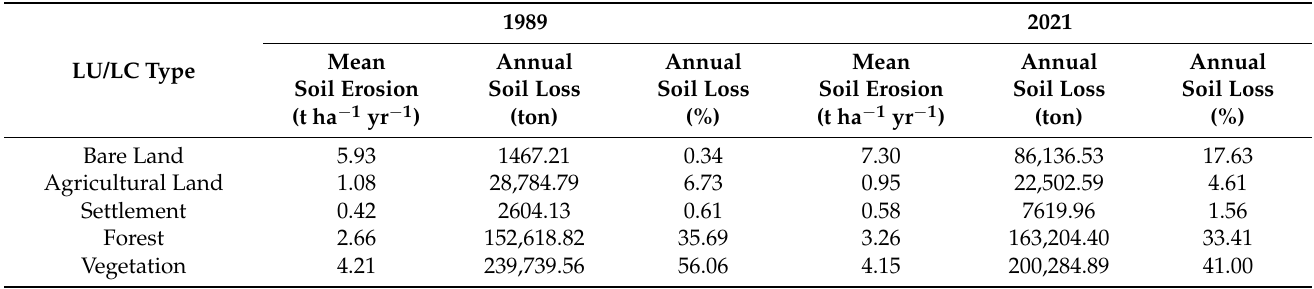
Table 14. Annual soil loss for specific LU/LC types of MORB in years 1989 and